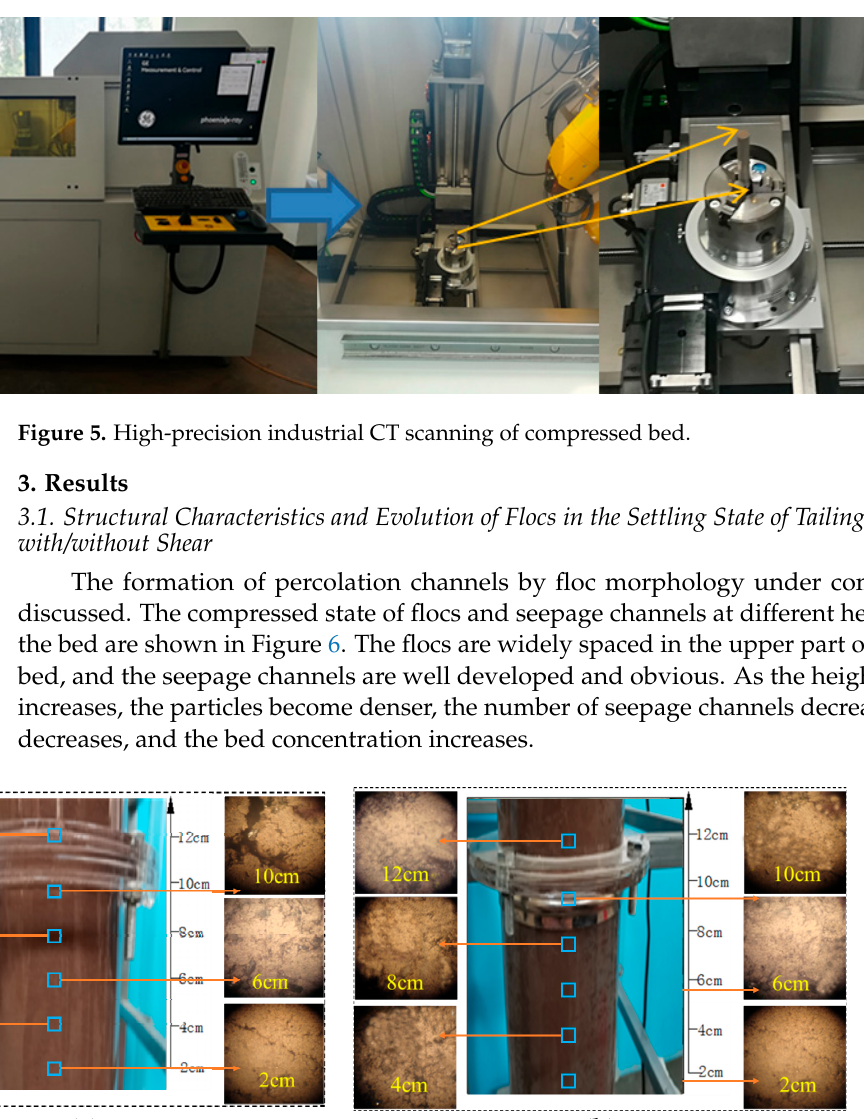
Figure 4. Bottom floc sampling. ( a ) Sampling without shear conditions; ( b ) Sampling under shear conditions.